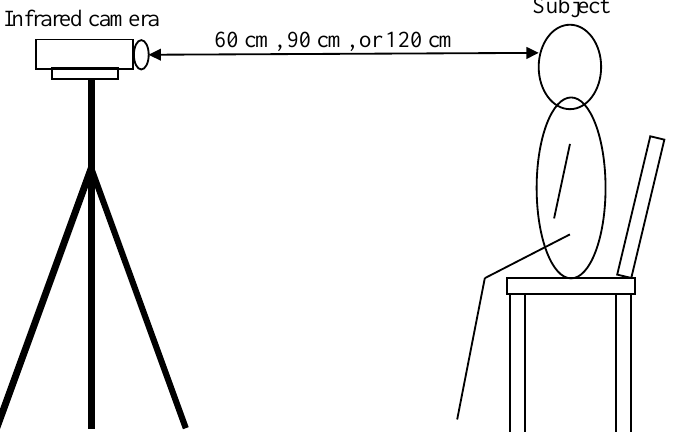
Figure 1. Experimental system. The distance between the subject and infrared camera was set at three different distances: 60 cm, 90 cm, or 120 cm.